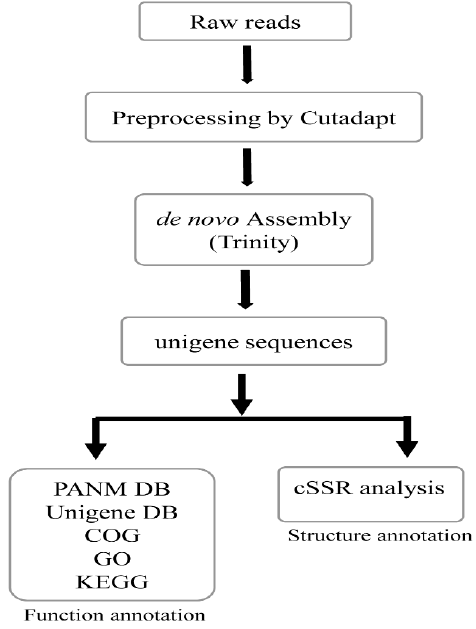
Figure 1. Schematic work-flow of the transcriptome analysis employed in the present study to annotate the unigenes of Korean endemic land snails, Aegista chejuensis and Aegista quelpartensis . Table 1. Statistics of transcriptome sequencing and assembling for A. chejuensis and A. quelpartensis. Statistics